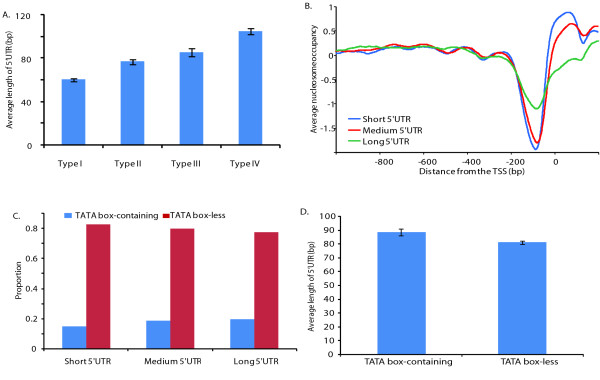
Intrinsic correlations among nucleosome positioning, presence/absence of TATA box and 5'UTR length. (A) Average 5'UTR lengths among the four gene groups clustered by k-mean clustering based on their nucleosome occupancy patterns. The mean value of each group is indicated by a bar and the error bars indicate one standard error. (B) The nucleosome occupancy in the 1201 bp window surrounding the TSS in the three groups of genes with different 5'UTR lengths. The TSS proximal region of long 5'UTR genes has the highest nucleosome occupancy. (C) The proportion of TATA box-containing genes and TATA box-less genes in each 5'UTR length group of genes. The long 5'UTR genes have the highest proportion of TATA box-containing genes, but the lowest proportion of TATA box-less genes. (D) TATA box-containing genes have slightly longer 5'UTRs than do TATA box-less genes.